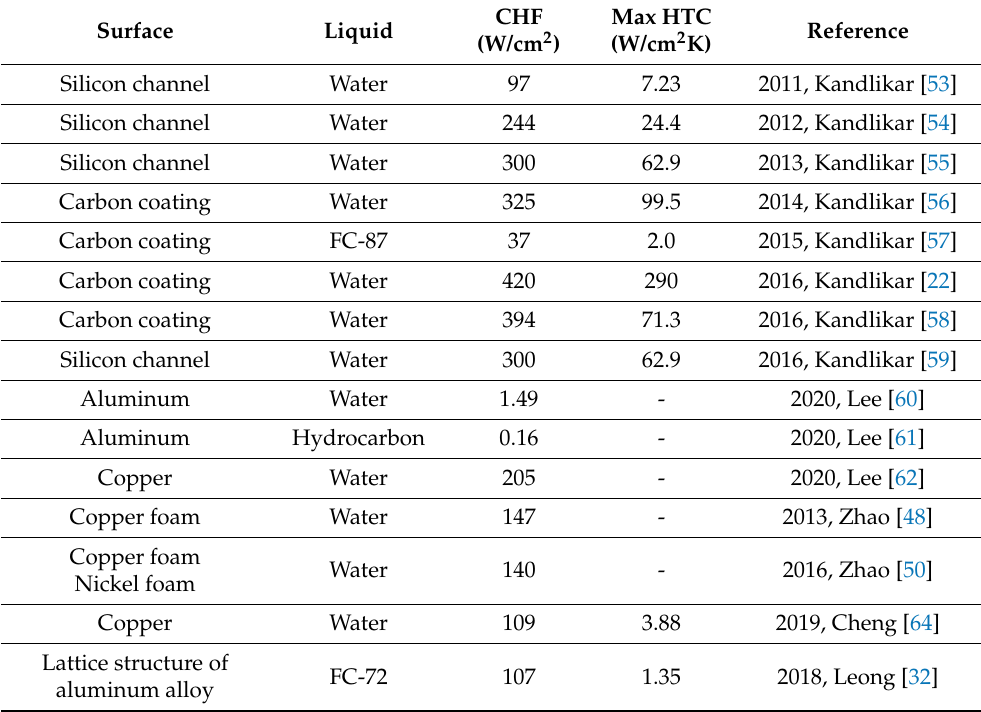
Table 4. Experiments of structure